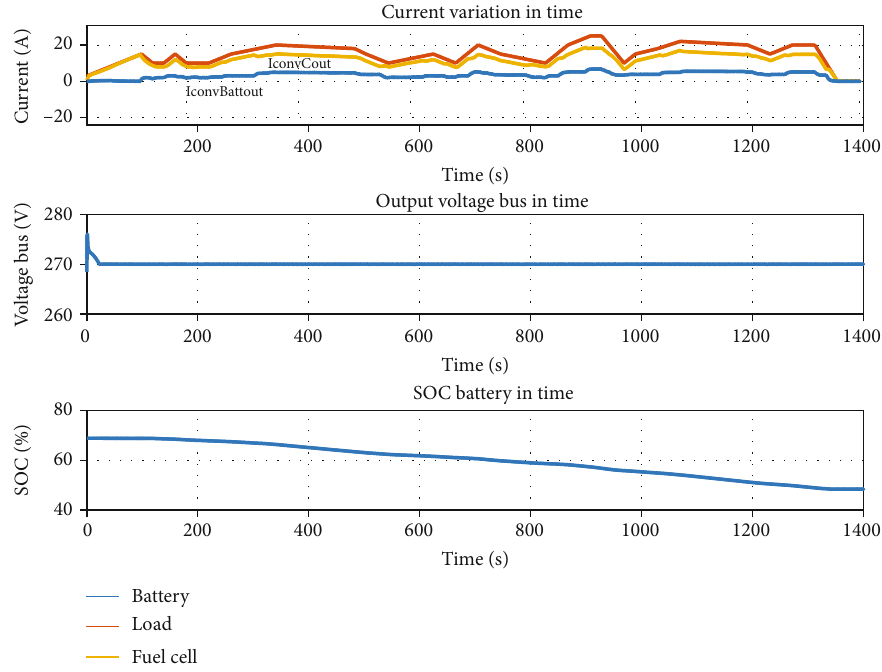
Figure 15: Simulation results for load pro fi le used in case